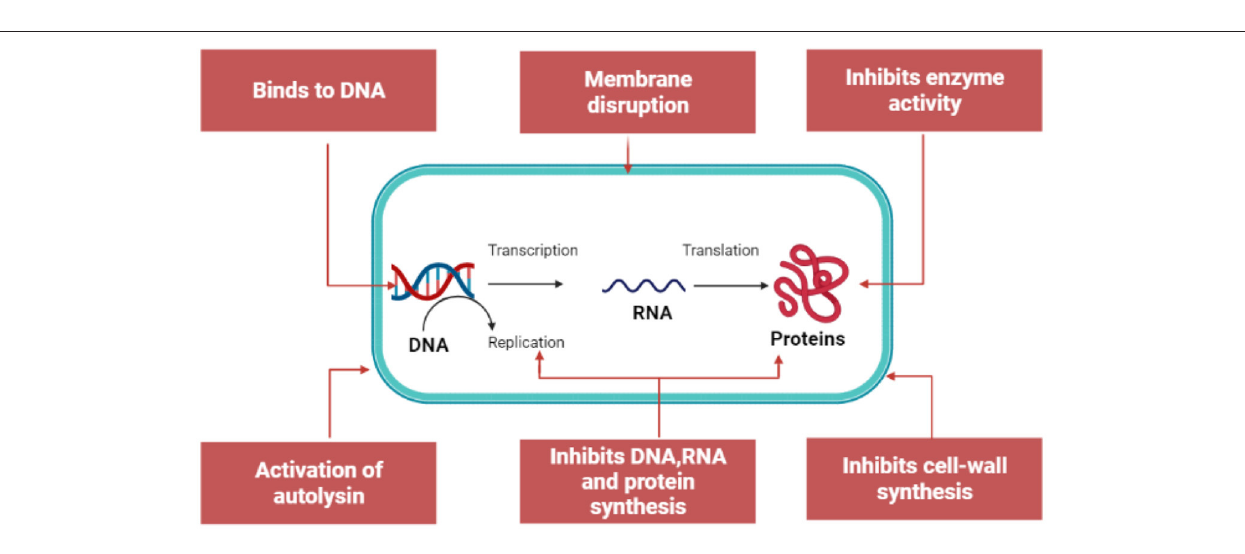
FIGURE 4 | Mechanism for intracellular antimicrobial peptide activity. The image was created using BioRender illustrator